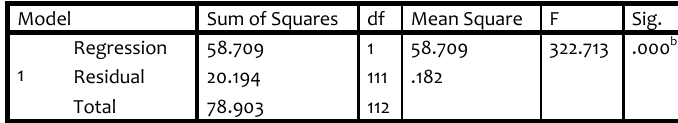
Table 6: ANOVA Table for Pedagogical Readiness